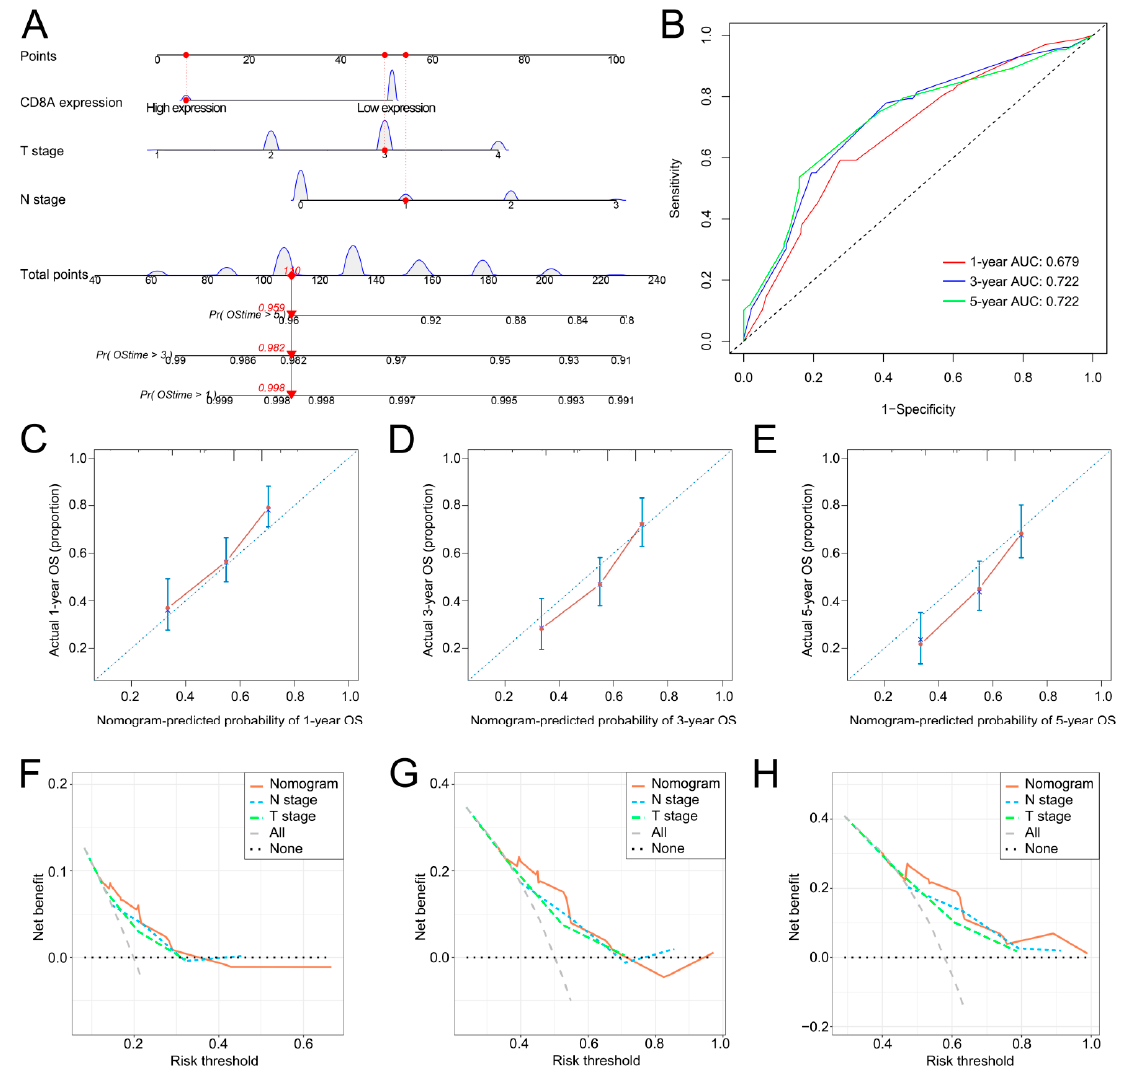
Figure 4. The construction and performance of the CD8A-based nomogram in TCGA. ( A ) CD8A- based nomogram for predicting the probability of 1-, 3- and 5-year OS. ( B ) ROC curves to predict the 1-, 3- and 5-year OS according to the CD8A-based nomogram. ( C – E ) Calibration plots of the CD8A-based nomogram for predicting the probability of 1-, 3- and 5-year OS. ( F – H ) DCA of the CD8A-based nomogram predicting 1-, 3- and 5-year OS. TCGA, The Cancer Genome Atlas; OS, overall survival; BCa, bladder cancer; ROC, receiver operating characteristic curve; DCA, decision curve analysis.